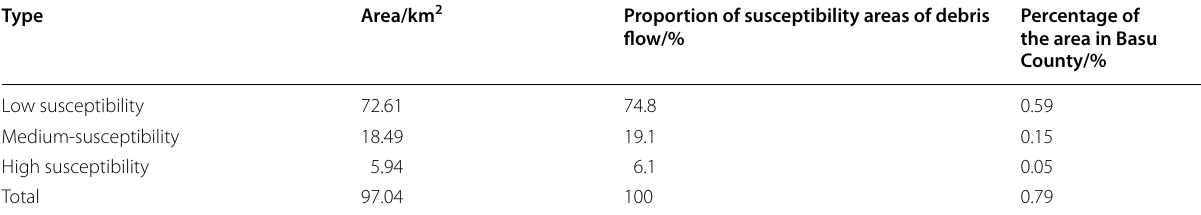
Table 4 Statistics of different debris flow susceptibility classes in Basu County